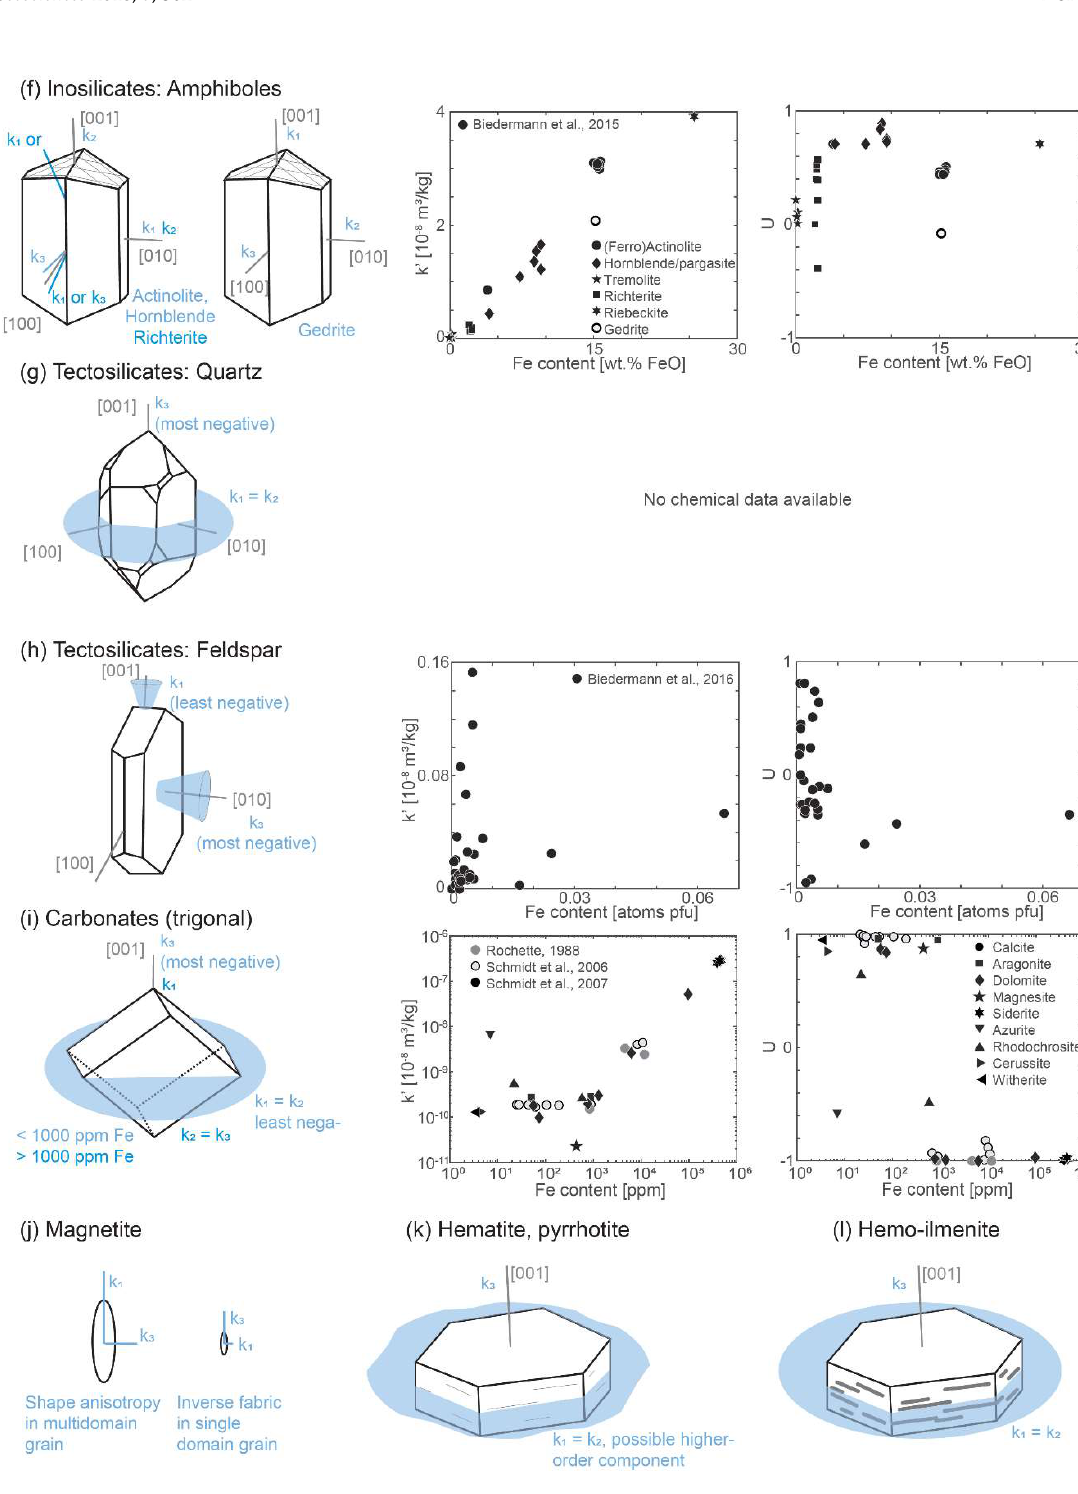
Figure 1. Principal directions, degree ( k (cid:48) ) and shape of anisotropy ( U ) as a function of Fe content for silicates, carbonates and some ferromagnetic minerals.